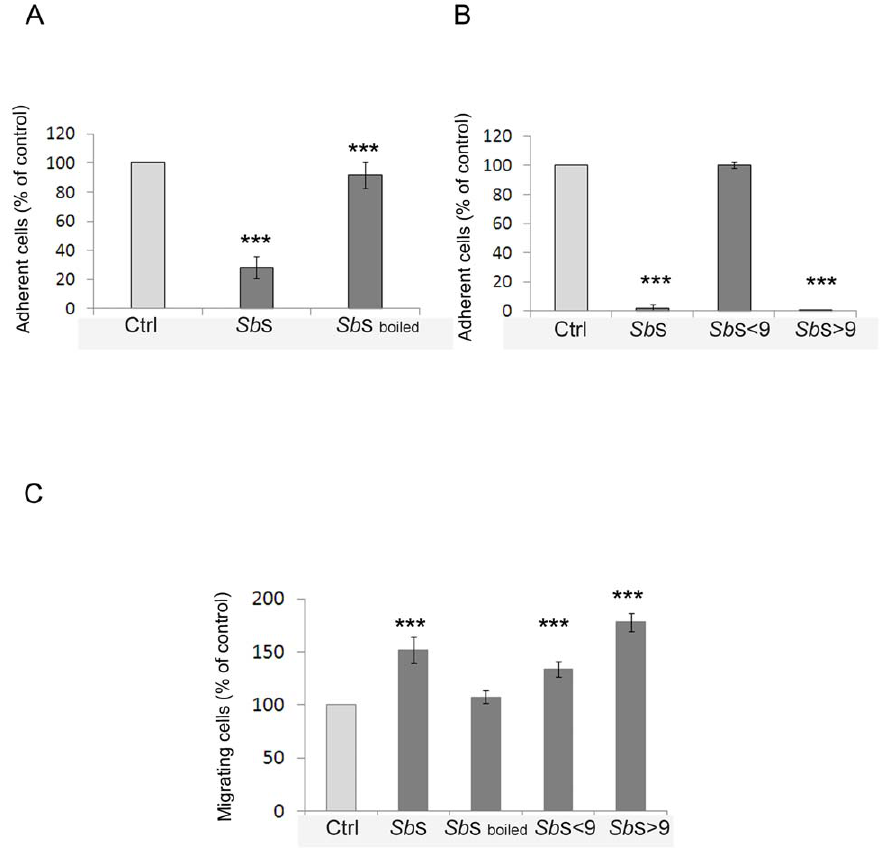
Figure 9. Sb secretes several molecules that differentially regulate both cell adhesion and migration. (A) Isolated HCT-8/E11 cells were treated with or without Sb S ( Sb S), boiled Sb S ( Sb S boiled) and plated on 3.15 m g/ml vitronectin. Cell-vitronectin adhesion was evaluated as described in Methods. Results are expressed as the percentage of cell adhesion. Data represent the mean + SD of 3 separate experiments. (B) Isolated HCT-8/E11 cells were treated with or without Sb S ( Sb S), or fractionated Sb S ( . 9 kDa or , 9 kDa) and plated on 3.15 m g/ml vitronectin. Cell-vitronectin adhesion was evaluated as described in Methods. Results are expressed as the percentage of cell adhesion. Data represent the mean + SD of 3 separate experiments. (C) HCT-8/E11 cell monolayers were wounded and incubated without (Ctrl) or with Sb S ( Sb S), boiled Sb S ( Sb S boiled ) or fractionated Sb supernatant ( . 9 kDa or , 9 kDa) for 5 h. Wound closure was determined as described in Methods. Results are expressed as the percentage of cell migration compared to control. Data represent the mean + SD of 2 separate experiments. *** P ,